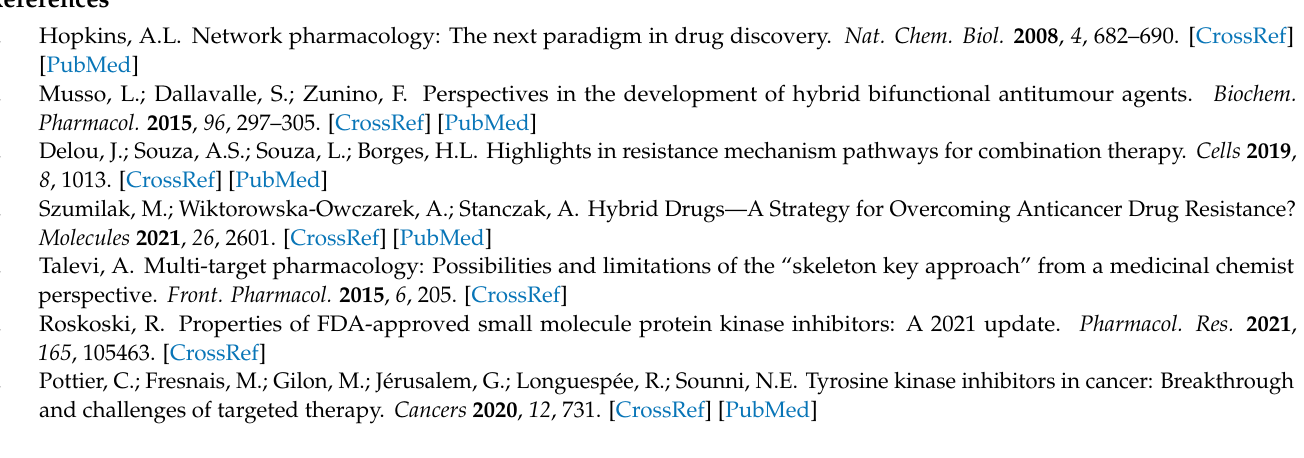
(Table S5); Applicability Domain Evaluation of External-Test set (Table S6a,b); Applicability Domain Optimization of Similarity Parameter (Table S7); Characteristics of Training Data (Table S8); Details for Target Proteins of Research Interest (Table